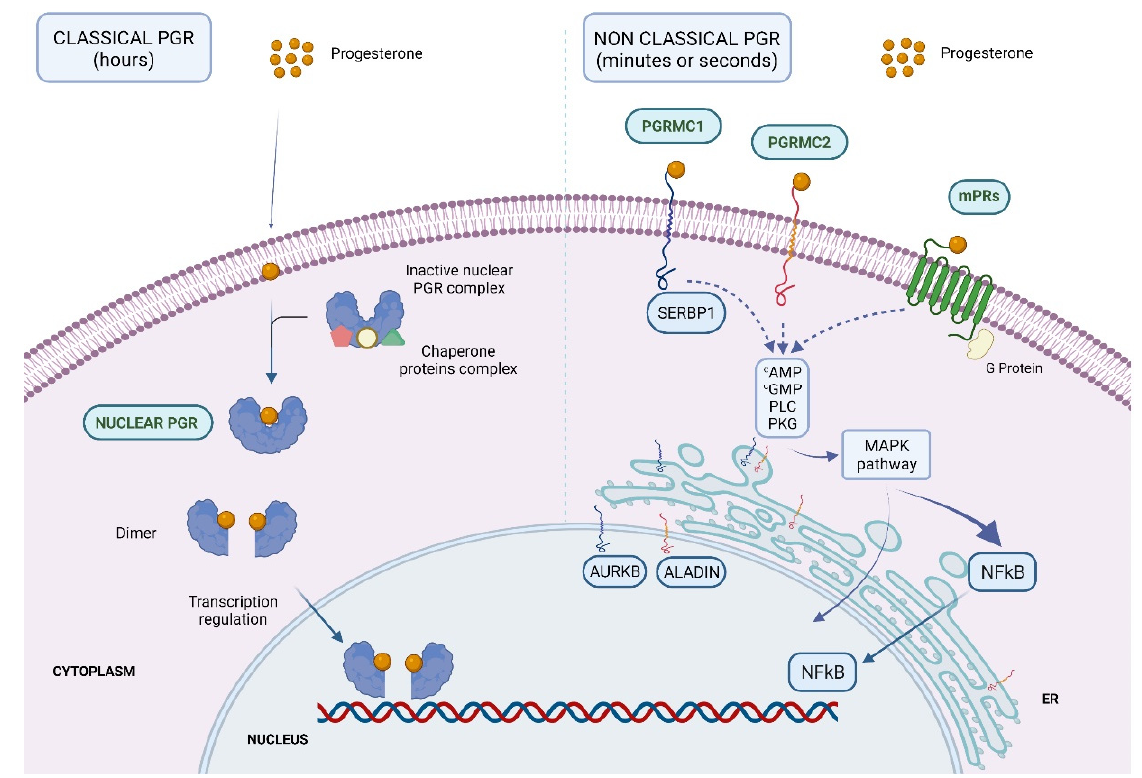
Figure 2. Graphic representation showing the subcellular localization and biological processes for classical ( left ) and non-classical ( right ) PGR in the cell and their interaction with proteins. ER = endoplasmic reticulum. Created with BioRender.com [47].